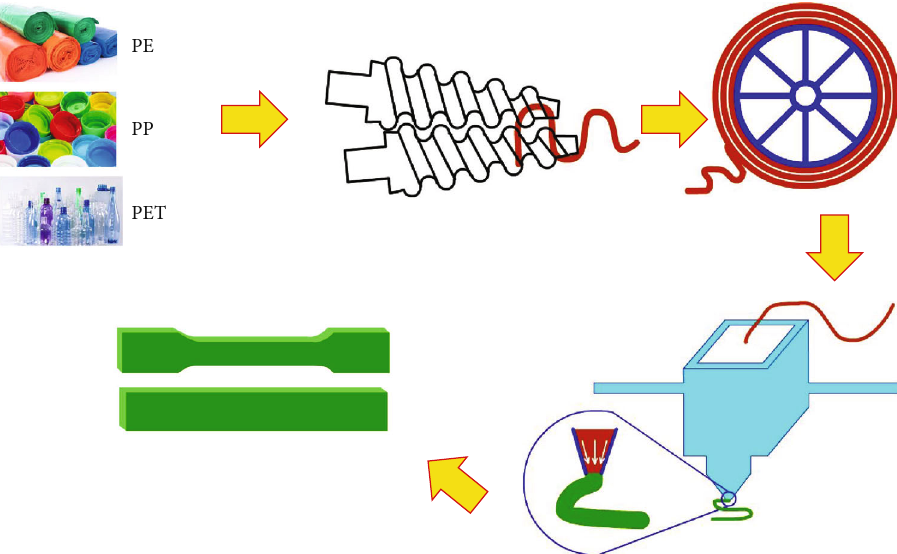
Figure 1: The process of 3D printing